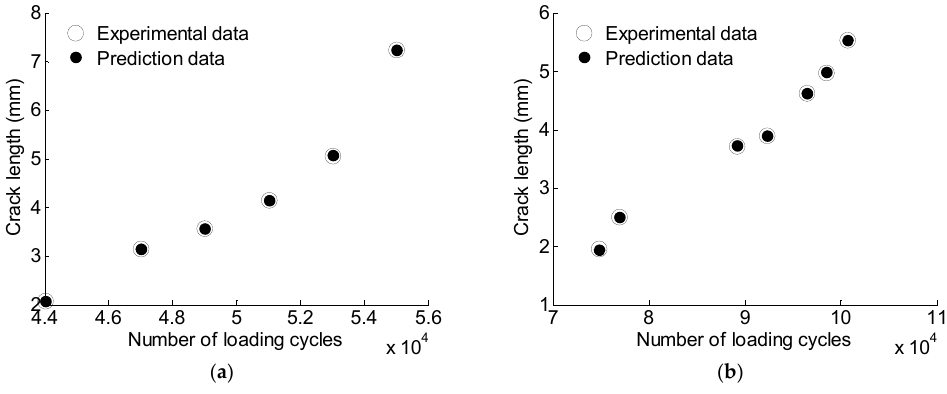
Figure 23. The prediction data for S6 and S7 using GA based LS-SVM. ( a ) S6; ( b ) S7. Table 9. The predicted MRE of S6 and S7.